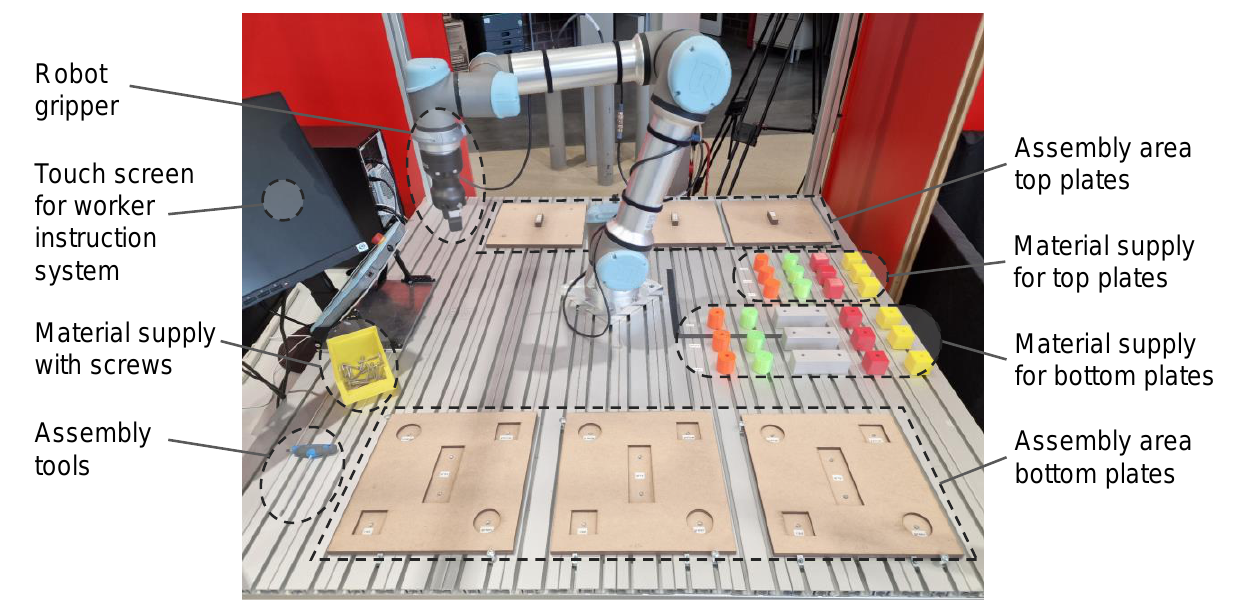
Figure 12. Experimental setup of the collaborative assembly station for the study.